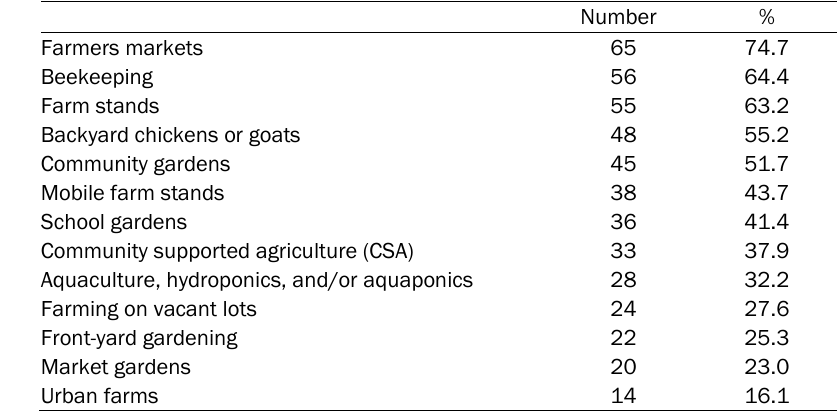
Table 6. Current LFP Activities in Respondents’ Communities ( n=